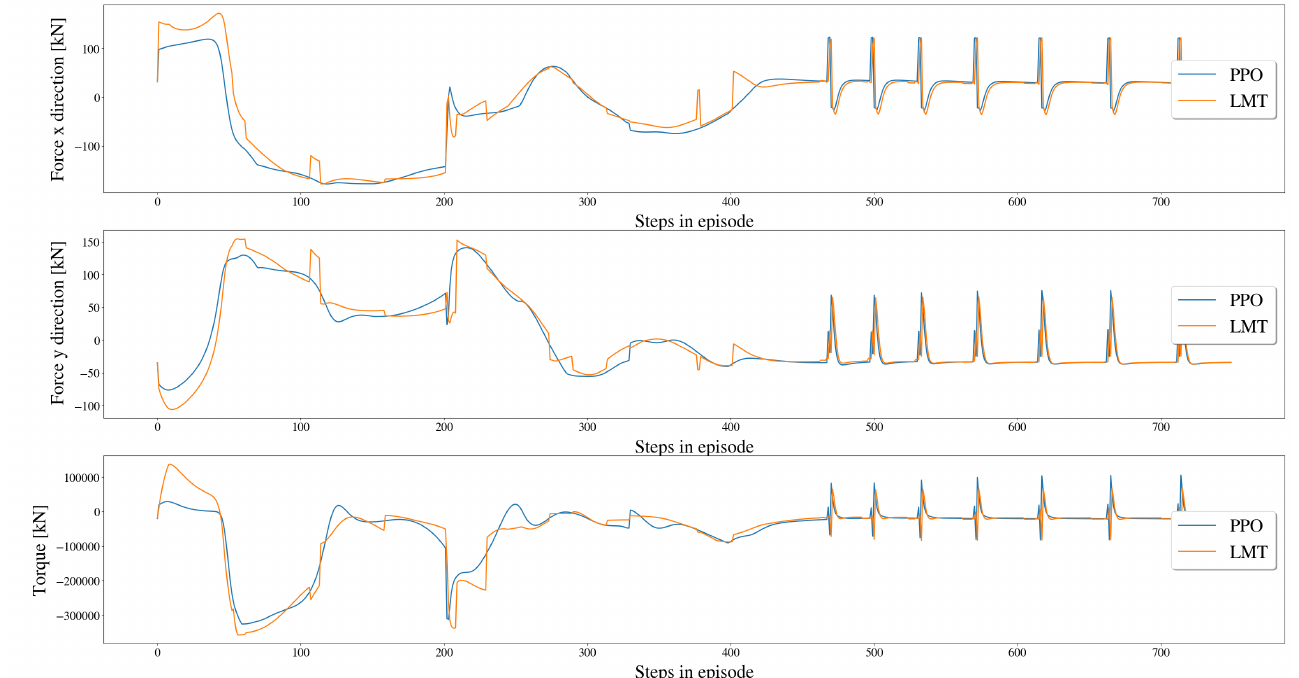
Figure 9. Plot of total force and moment predicted by both the LMT and the PPO-policy for an episode where the PPO-policy actions are given to the